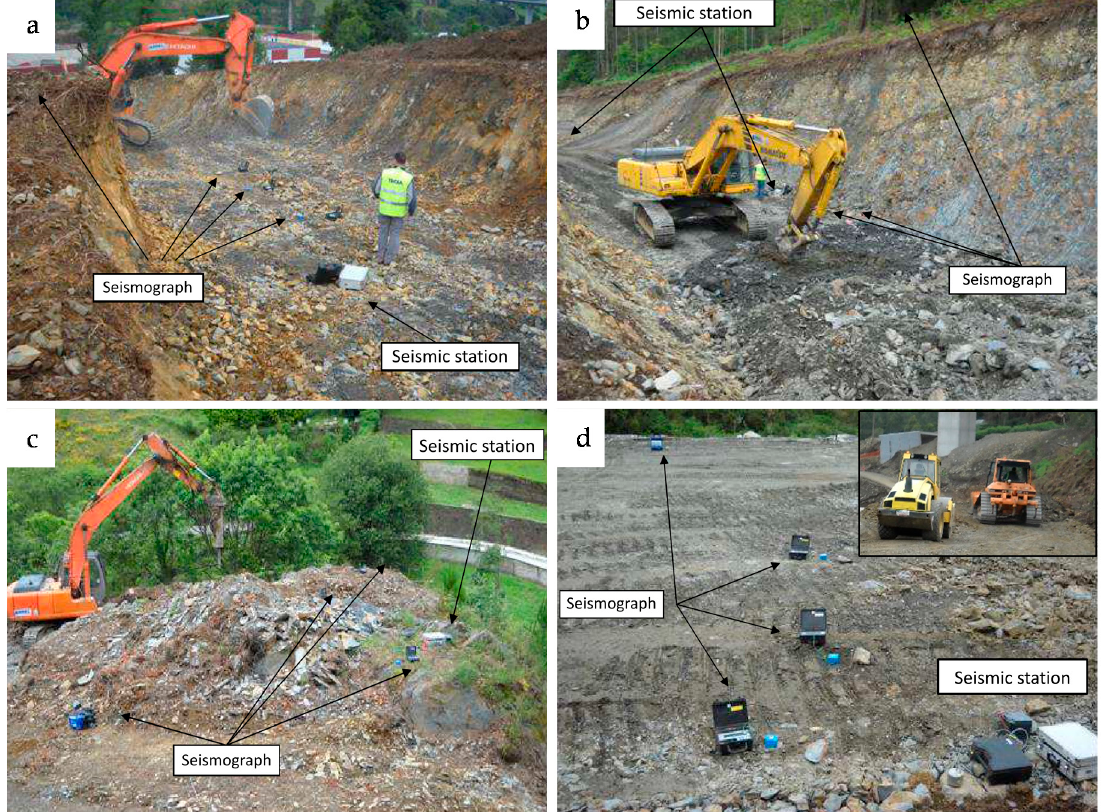
Figure 3. Layout of the equipment for monitoring the work of: a) V-type bucket, b) ripper c) hydraulic hammer and d) bulldozer and a vibrating roller.